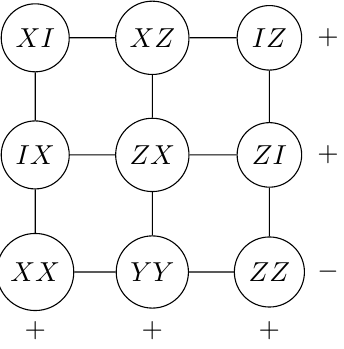
Figure 1. The Peres–Mermin magic square: all two-qubit observables on the same row/column mutually commute. The product of observables in each row/column is equal to ± I 4 as indicated by the signs. The measurement of each two-qubit observable yields ± 1 . One observes that there is no deterministic classical function that would predict the outcomes for each node and satisfy all the signs